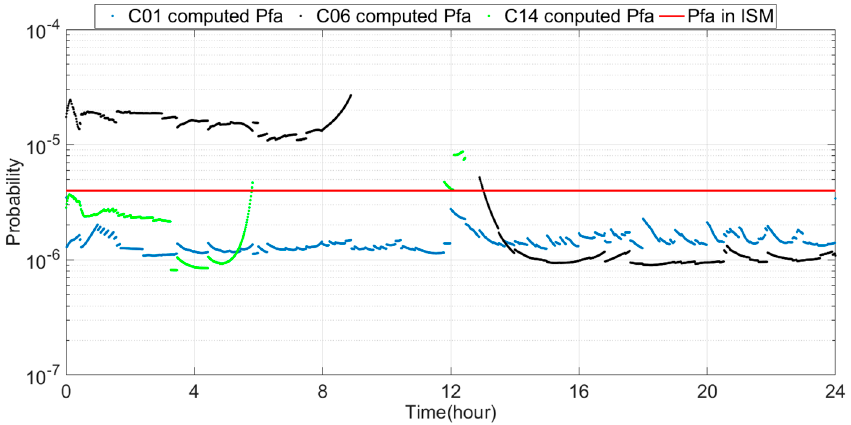
Figure 12. Computed Pfa of satellites C01, C06 and C14 per minute.